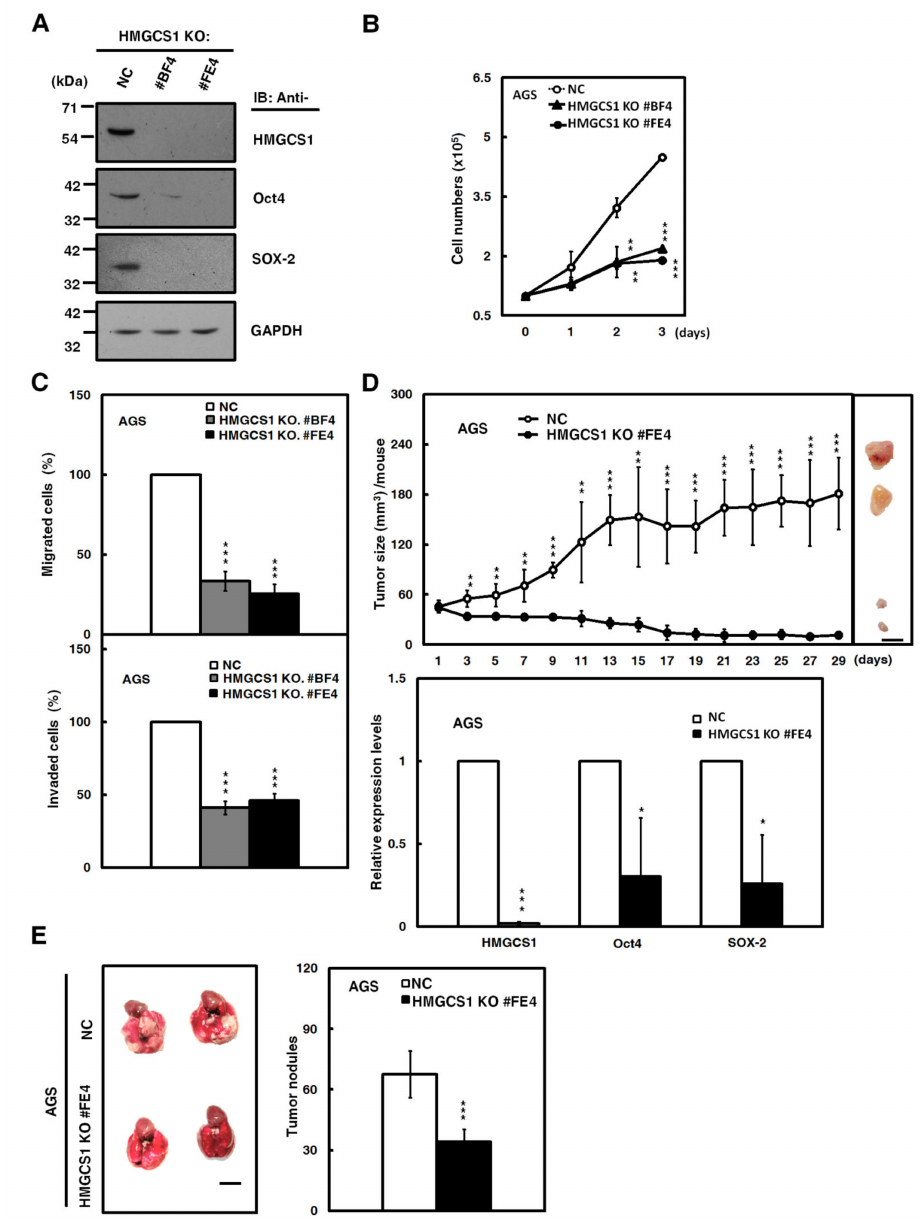
Figure 4. The Clustered Regularly Interspaced Short Palindromic Repeats-associated protein-9 nuclease (CRISPR-Cas9)-mediated HMGCS1 knockout suppresses growth and progression of gastric cancer cells. ( A ) Whole-cell extracts of HMGCS1 knockout (KO) #BF4 and #FE4 cells and negative control (NC) cells were prepared for Western blot analysis using anti-HMGCS1, anti-Oct4, anti-SOX-2, and anti-GAPDH antibodies. ( B , C ) HMGCS1 KO #BF4 and #FE4 cells and negative control cells were seeded for cell counting by trypan blue exclusion method ( B ), migration, and invasion ( C ). Mean ± SD ( n = 3). ( D ) HMGCS1 KO #FE4 cells and negative control cells were subcutaneously injected into nude mice ( n = 5 per group) for measurement of tumor sizes at the time indicated (upper). Bar, 0.5 cm. The mice were sacrificed on day 29 and then subcutaneous tumors were excised for the detection of HMGCS1, Oct4, and SOX-2 transcripts using quantitative real-time PCR (lower). Mean ± SD. ( E ) HMGCS1 KO #FE4 cells and negative control cells were injected into NOD-SCID mice ( n = 4 per group) by tail vein injection for measurement of metastatic nodules in lungs. After 11 weeks, the mice were sacrificed and the metastatic nodules in lungs of the treated mice were also counted by gross and microscopic examination. Mean ± SD. *, p < 0.05; **, p < 0.01; ***, p <